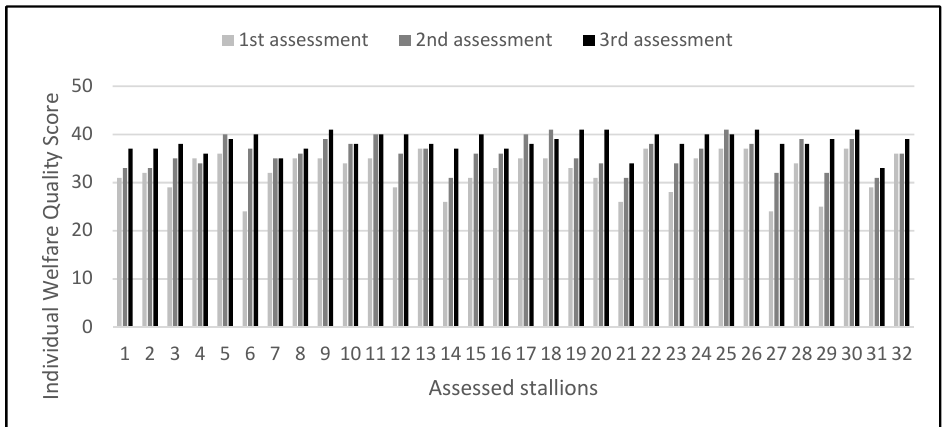
Figure 1. Evolution of the IQWS in the 32 stallions within the three welfare assessments performed.